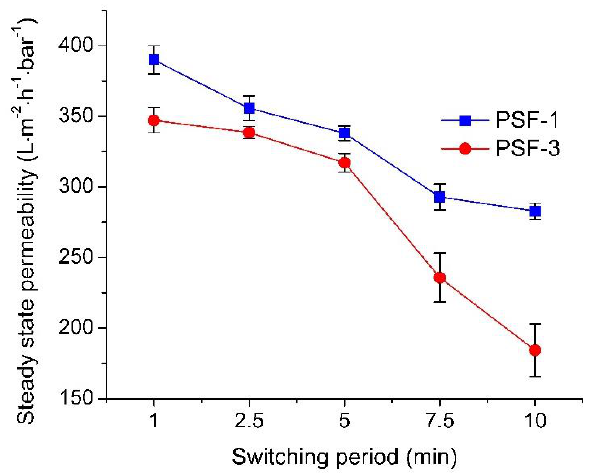
Figure 6. The e ff ects of switching period on the steady-state Figure 6. The effects of switching period on the steady-state permeability.